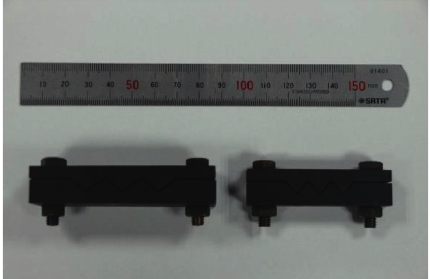
Figure 4: Corrugated sample